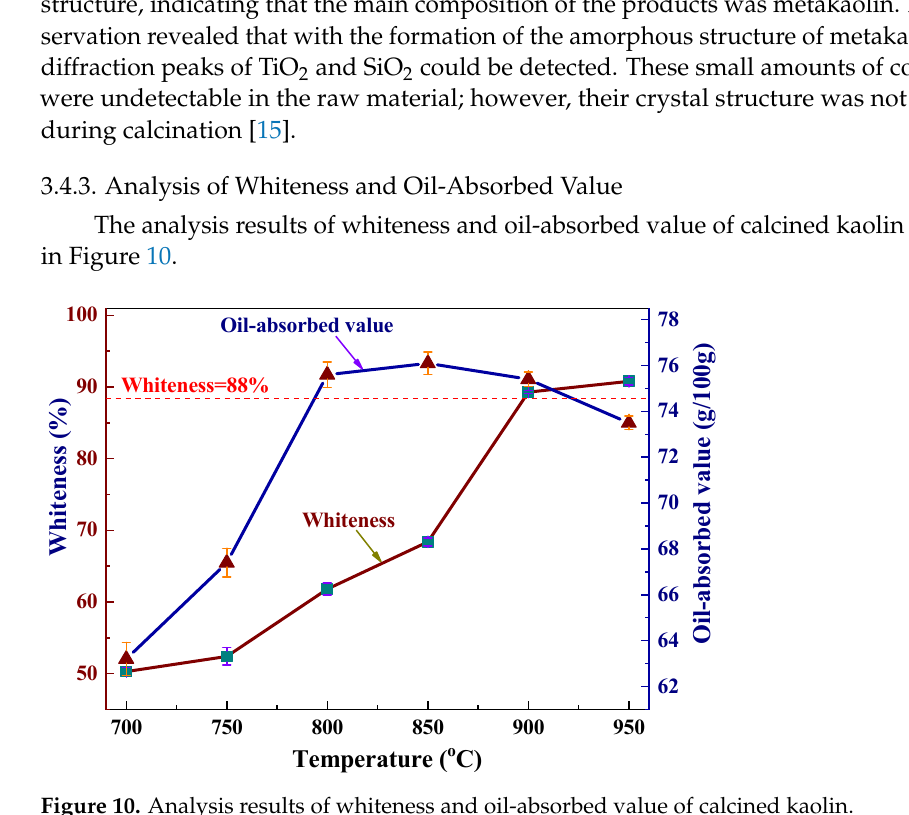
Figure 10. Analysis results of whiteness and oil-absorbed value of calcined kaolin.